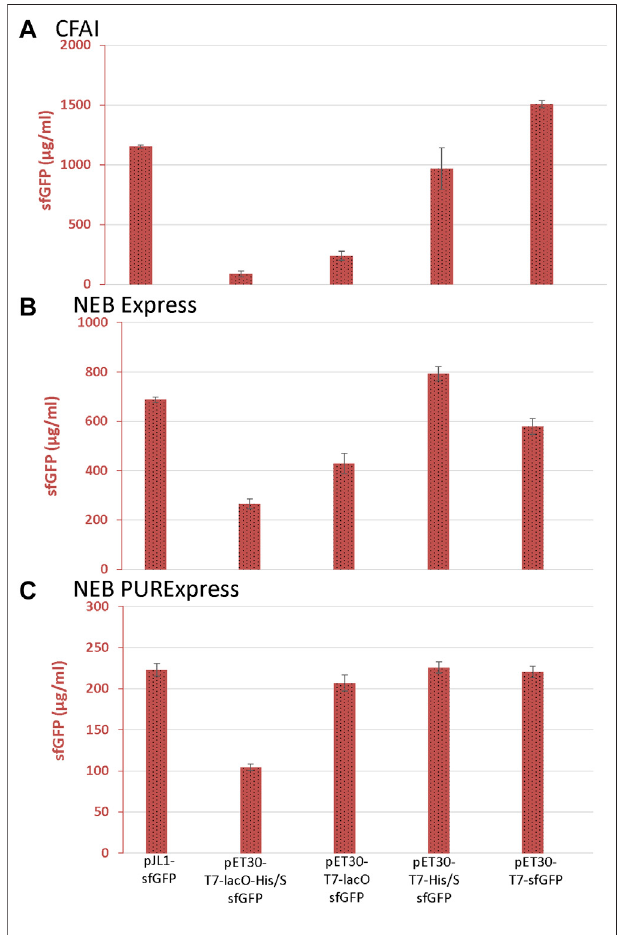
FIGURE 2 | sfGFP expression from the CFAI-based, NEB Express, and NEB PURExpress CFPS systems. The sfGFP yields from (A) CFAI-based, (B) NEBExpress, and (C) NEB PURExpress CFPS systems determined by fl uorescence. Data are presented as mean ± s.d. ( n =